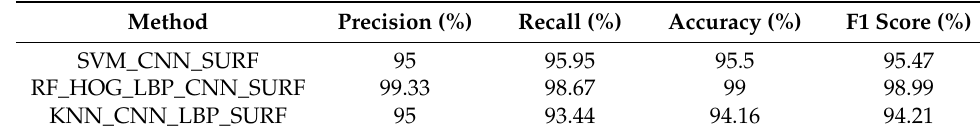
Table 3. The Best Performing Proposed Algorithms on Testing Data.